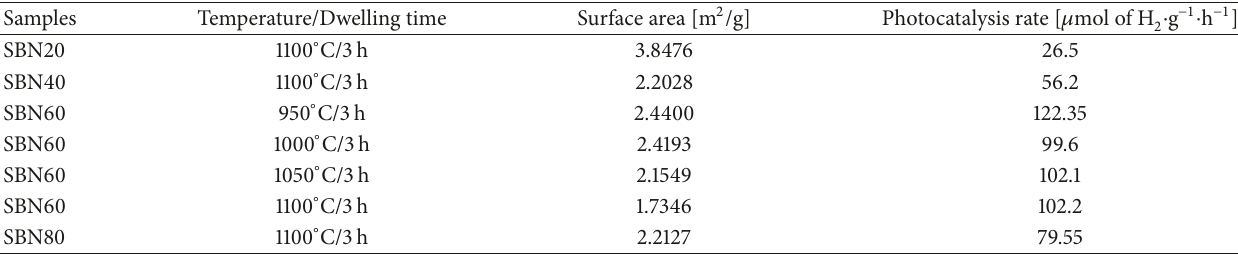
Table 1: Surface areas and photocatalytic rates for hydrogen production of the flux-prepared SBN nanocrystals.